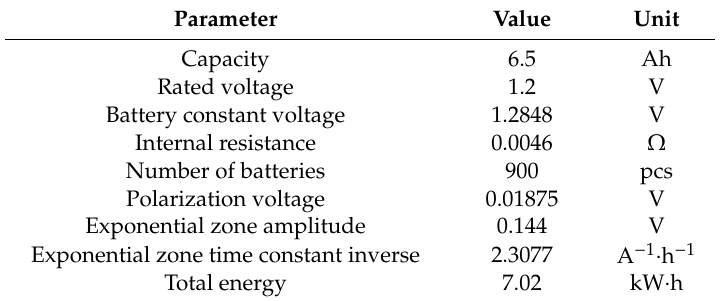
Table 3. Battery parameters.